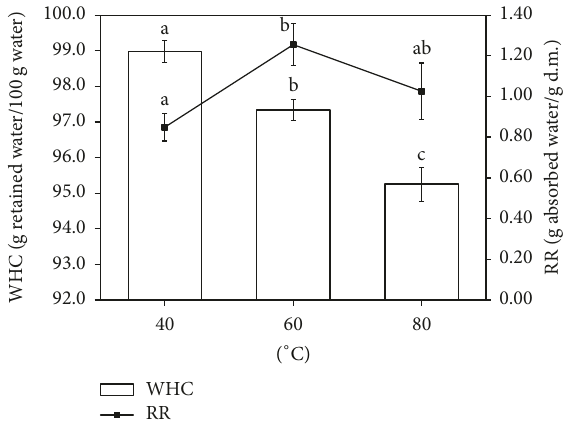
Figure 4: Effect of air-drying temperature on the rehydration ratio (RR) and the water holding capacity (WHC) for dry-rehydrated abalone samples. Identical letters above the bars indicate no signifi- cant difference ( 𝑝 < 0.05